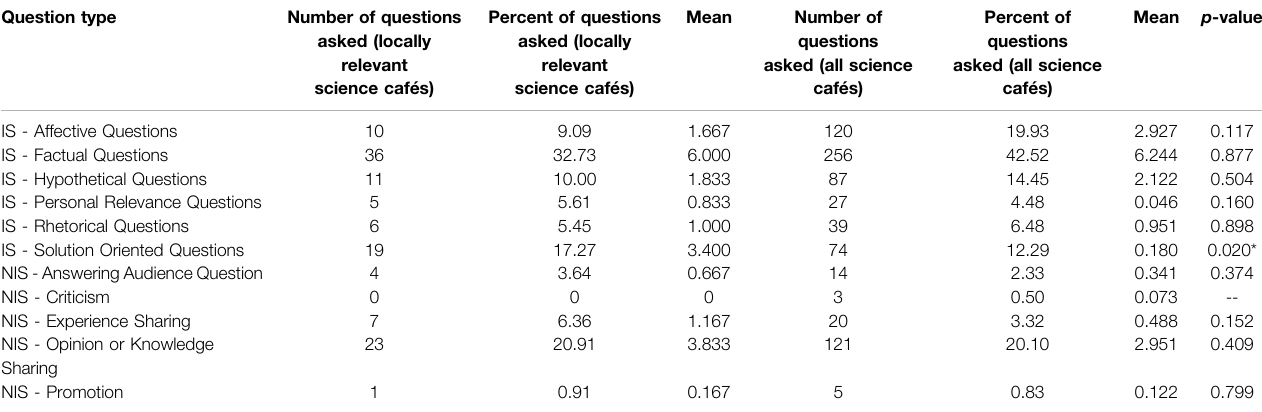
TABLE 6 | Comparison of question types at Science Café events featuring Locally-Relevant Topics ( n (cid:1) 6). Question type Number of questions